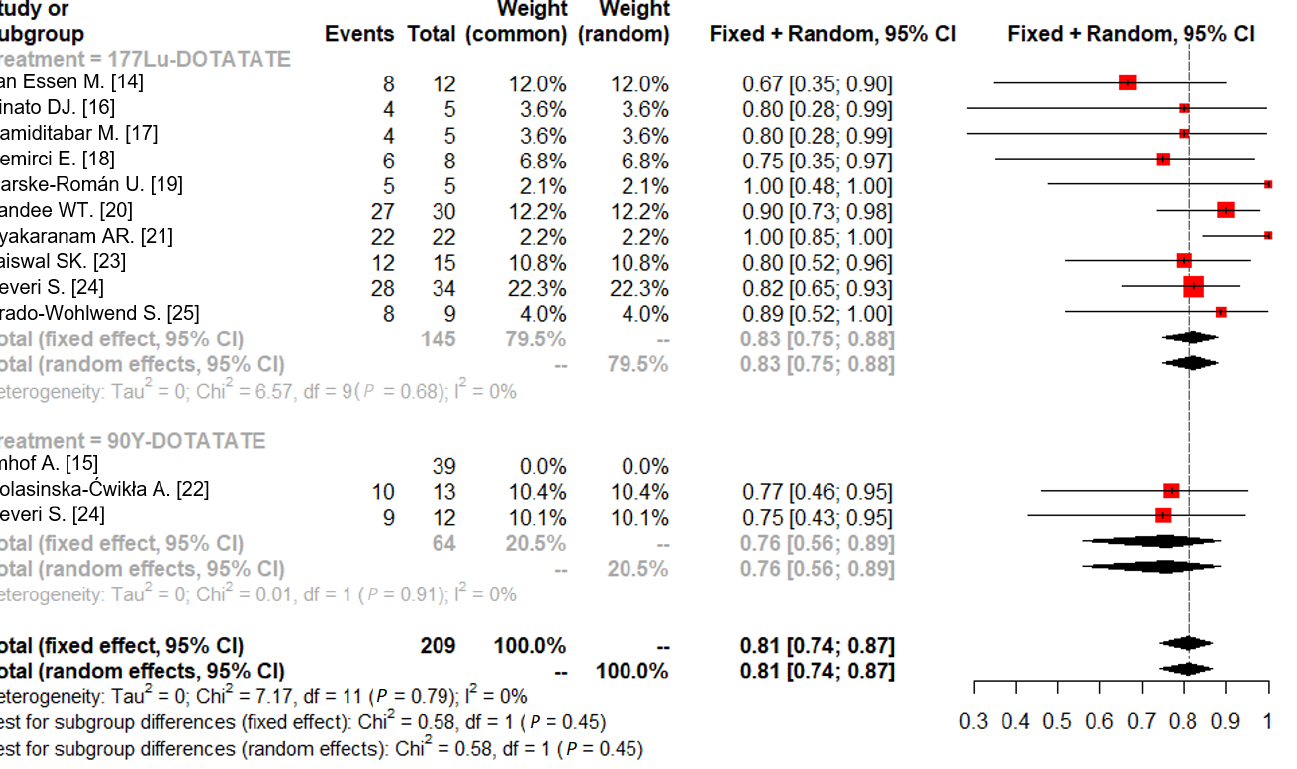
Figure 3. Forest plot for DCR according to 177Lu- and 90Y- PRRT treatments.